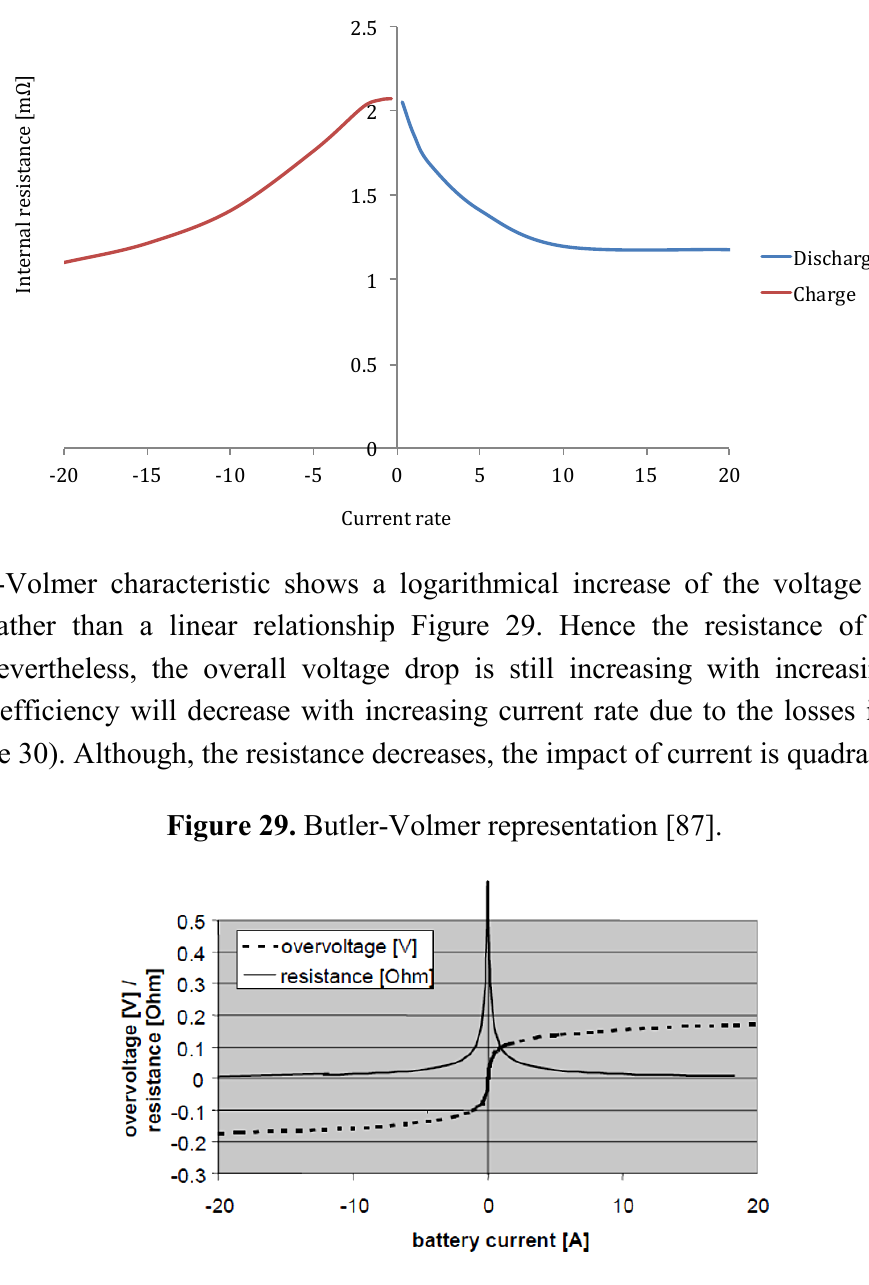
Figure 28. Resistance evolution in function of current rate [61].